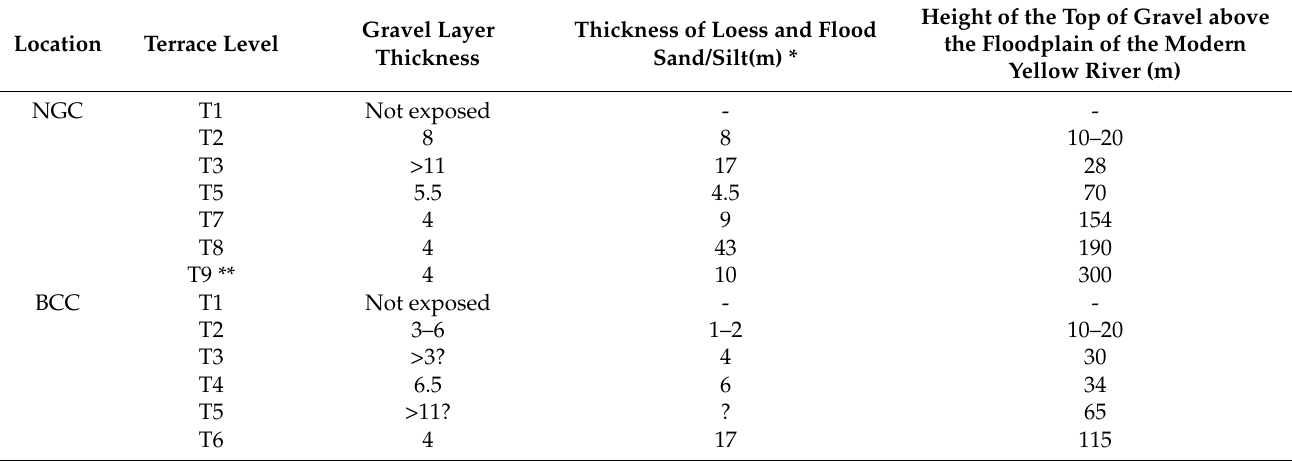
Table 1. Terrace level, the height of the top of the fluvial gravel above the floodplain of the modern Yellow River, the thickness of the gravel unit, and the thickness of the flood sand/silt and loess units. (“?” means the thickness is uncertain due to incomplete